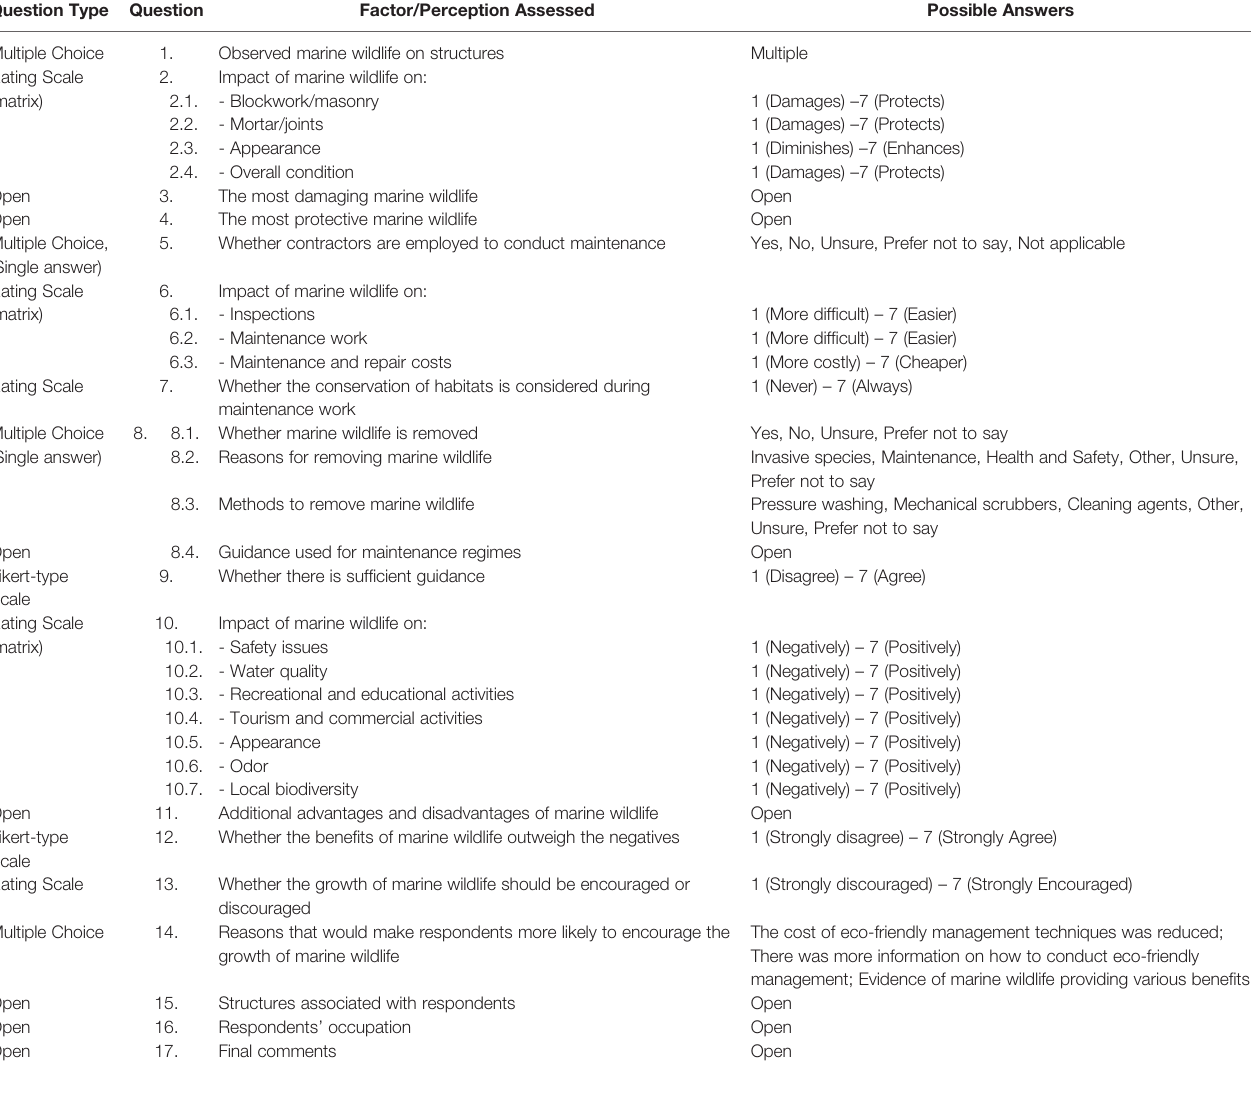
TABLE 1 | Questions and possible answers included in the